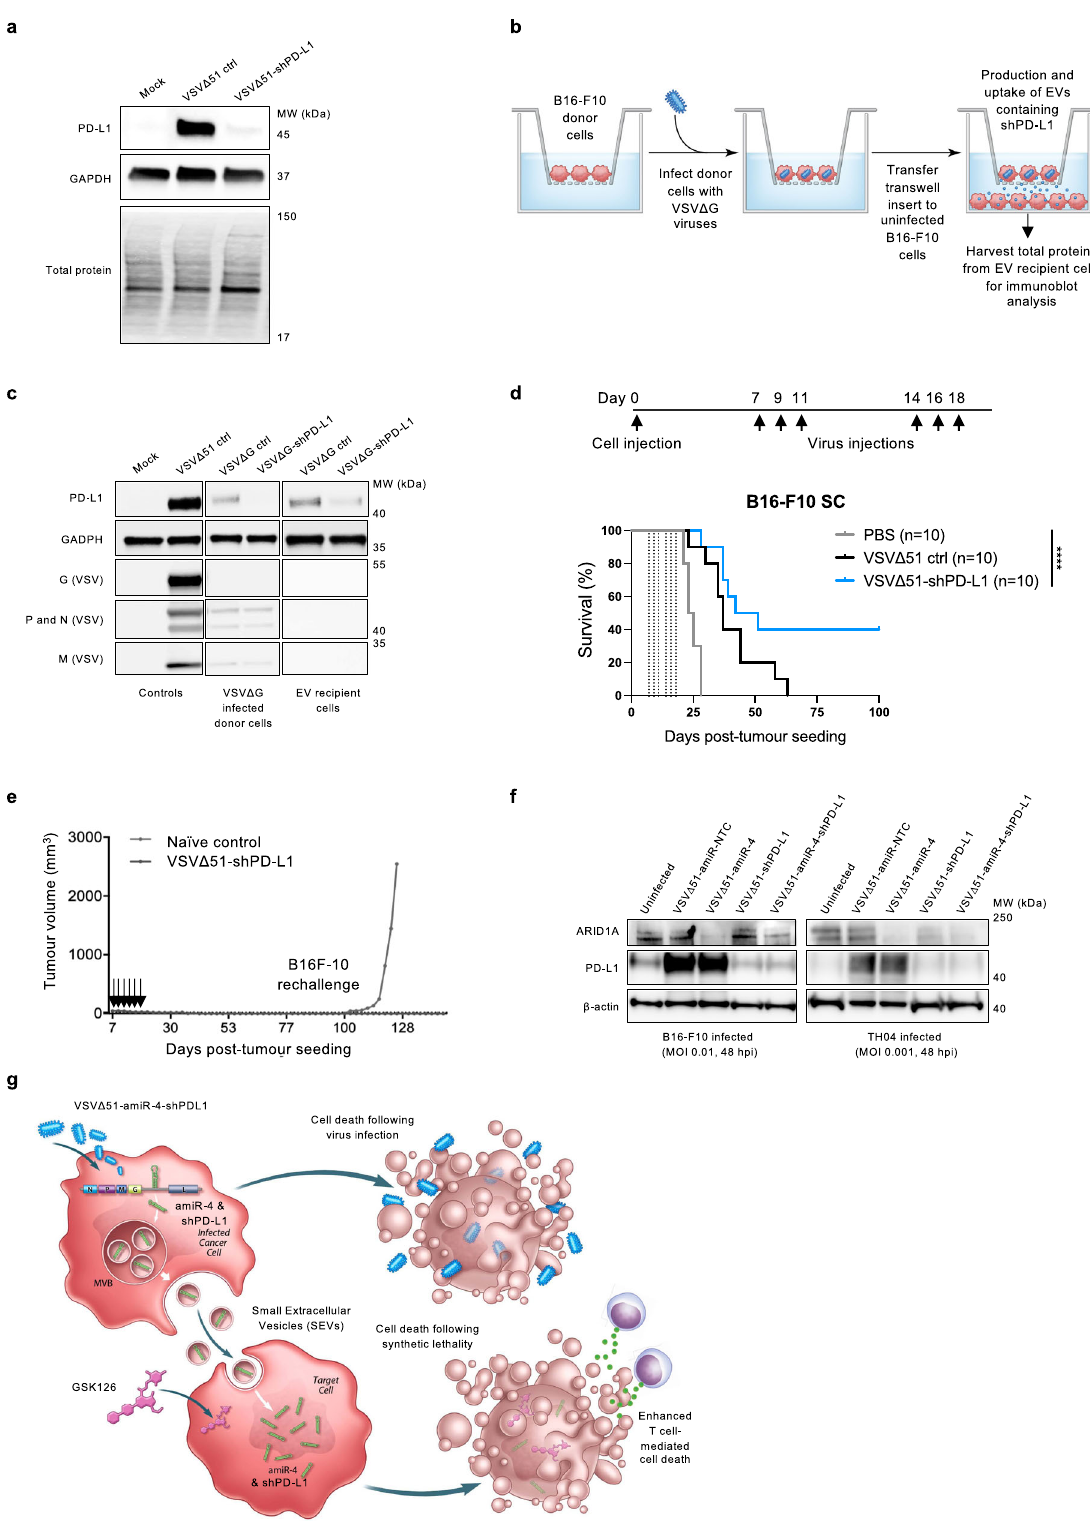
con fi rmed using western blotting, T7 endonuclease assay and Sanger sequencing. T7 endonuclease assay to con fi rm gRNA cleavage was performed using DNA from clonally derived cell lines (PANC1, 786-0 and 4T1) was extracted using the DNeasy Blood & Tissue kit (Qiagen). Genomic DNA was used as the template to Supplementary Table 4. PCR products were puri fi ed using the PureLink PCR Puri fi cation kit (Thermo Fisher). Puri fi ed DNA was quanti fi ed by Nanodrop, and 200 ng of DNA was mixed with 10× NEBuffer 2 and dH 2 O to a fi nal volume